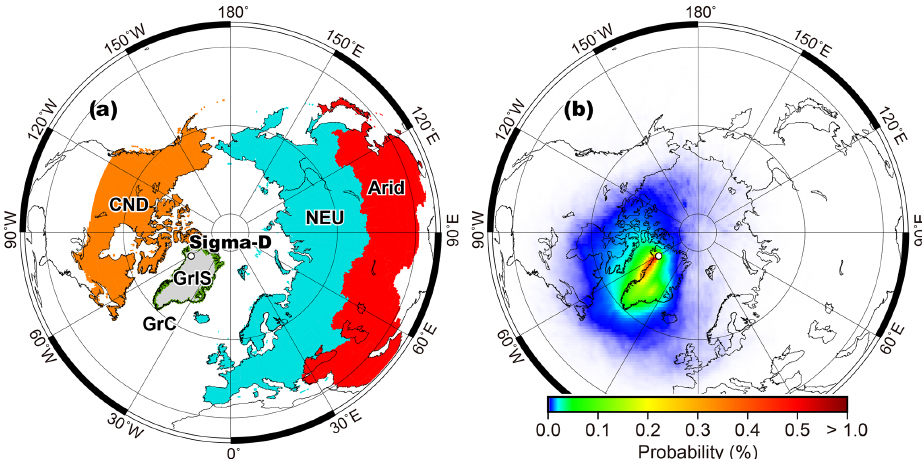
Figure 2. Map showing (a) the location of the SIGMA-D (Sigma-D) ice core site in Greenland and five regions for calculating regional contribution (GrIS: Greenland Ice Sheet, grey; GrC: Greenland coast, green; CND: Canada and Alaska, orange; NEU: northern Eurasia, light blue; Arid: arid regions including China, Central Asia, and the Middle East, red) and (b) the probability distribution of an air mass at the SIGMA-D site from a 7d three-dimensional back-trajectory analysis from 1958 to